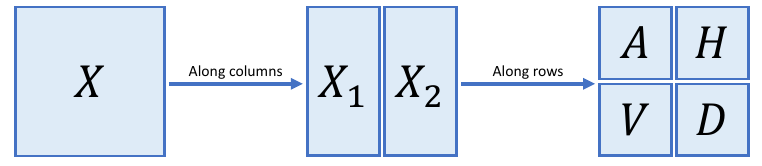
Figure 1. Illustration of 2D wavetlet transform